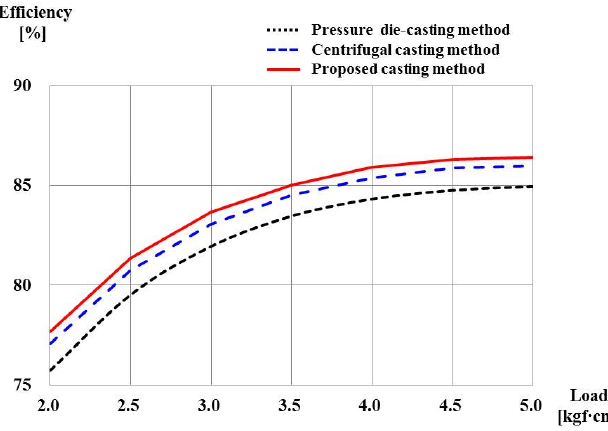
Figure 12. The efficiency of applying the stator #1 (220 V/50 Hz).